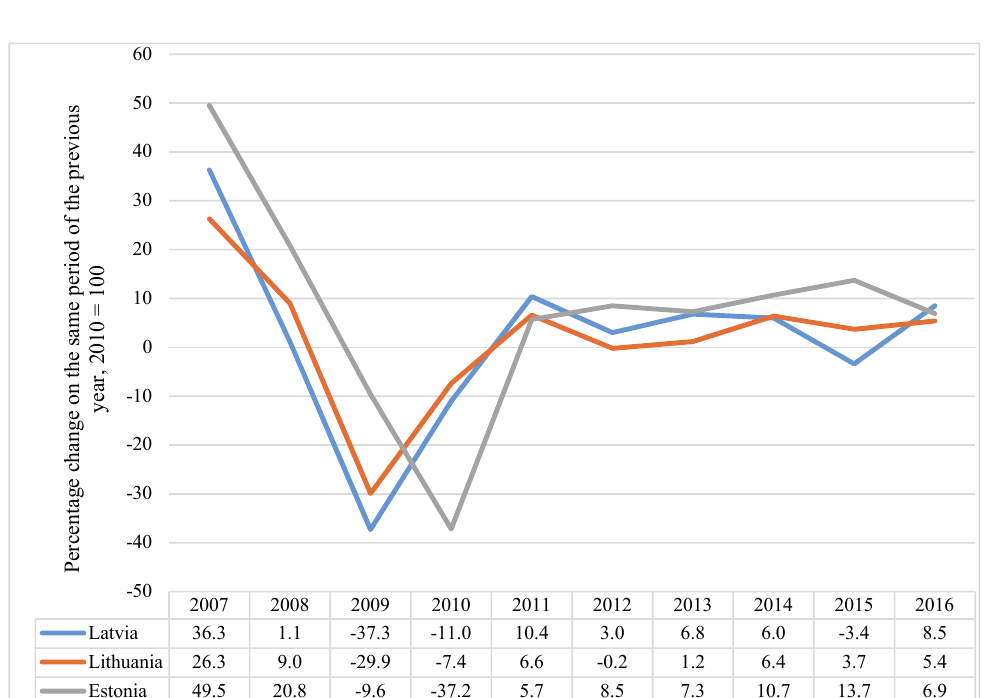
Fig. 3 . Residential Property Price Indices in the Baltic States [developed by the authors based on the data from OECD (n.